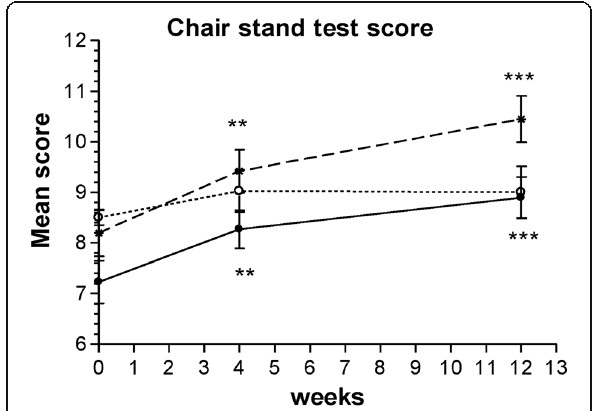
Fig. 2 The changes with time in the maximum number of chair stand repetitions possible in a 30-s period at weeks 0, 4, and 12 in the Curamin, CuraMed and placebo treatment groups. Within-group